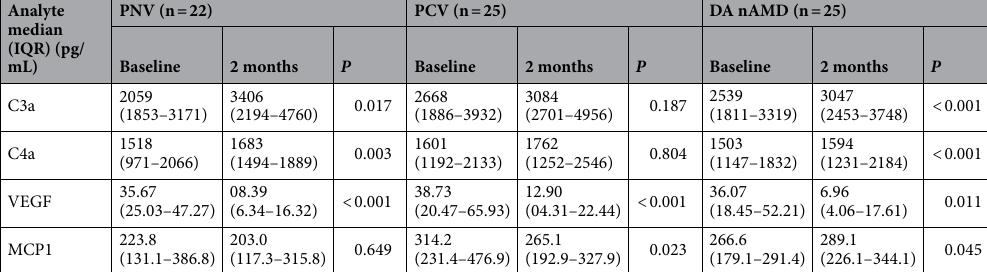
Table 3. Changes in Levels of complement factors and cytokines in the aqueous humor of patients with CNV. Changes in levels of complement factors and cytokines in the aqueous humor of eyes with choroidal neovascularization (CNV). Wilcoxon signed rank test was used for comparisons between baseline and 2 months. nAMD, neovascular age-related macular degeneration; PNV, pachychoroid neovasculopathy; PCV, polypoidal choroidal vasculopathy; DA nAMD, drusen associated neovascular age-related macular degeneration; IQR, interquartile range; C3a, complement component 3a; C4a, complement component 4a; VEGF, vascular endothelial growth factor; MCP-1, macrophage chemoattractant protein 1. The Mann– Whitney U-test was used for analysis between baseline and 2